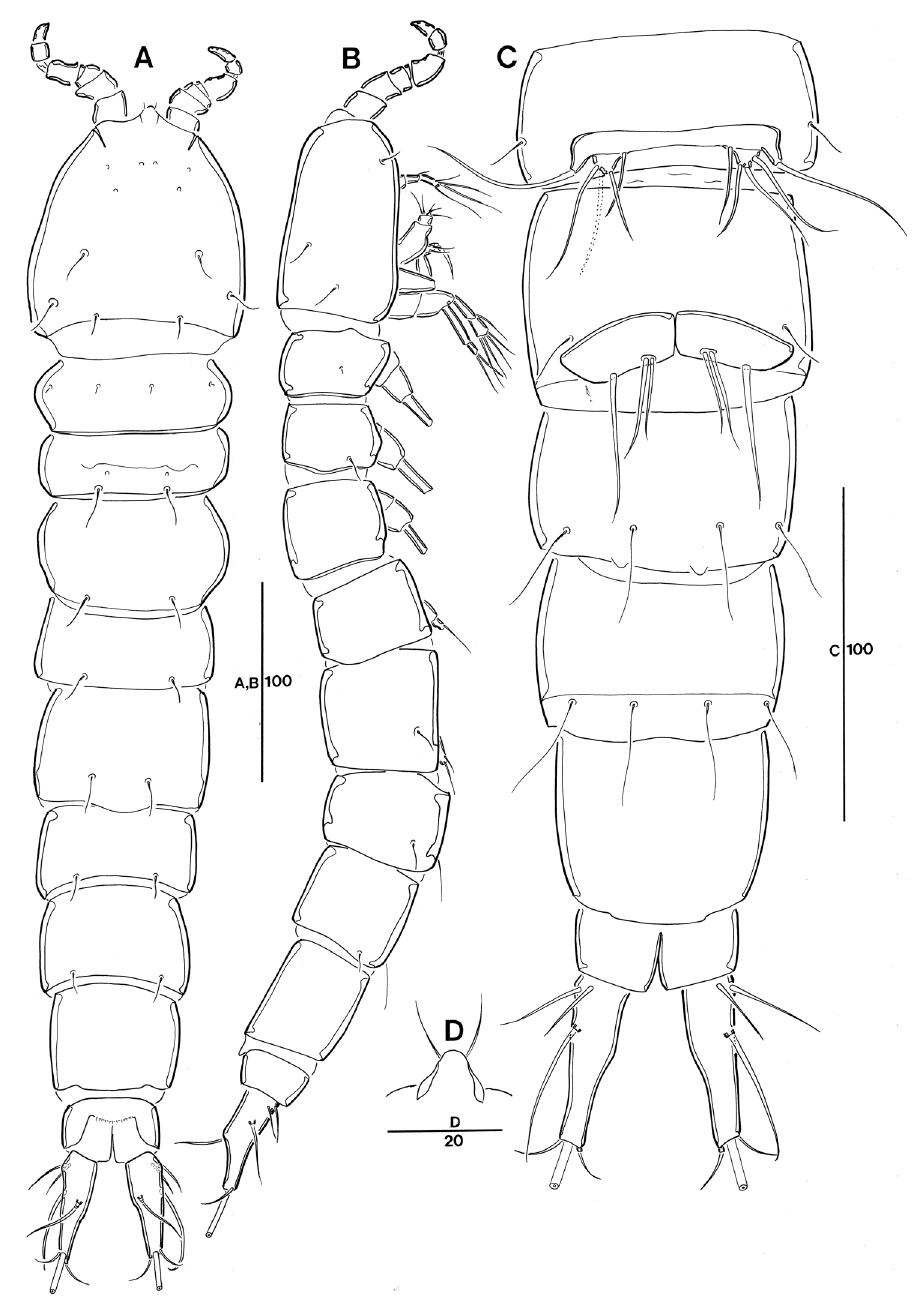
Figure 5. Leptopsyllus ( Leptopsyllus ) koreanus sp. n. ( ♂ ). A habitus, dorsal B habitus, lateral C urosome, ventral D rostrum. Scale bars are in